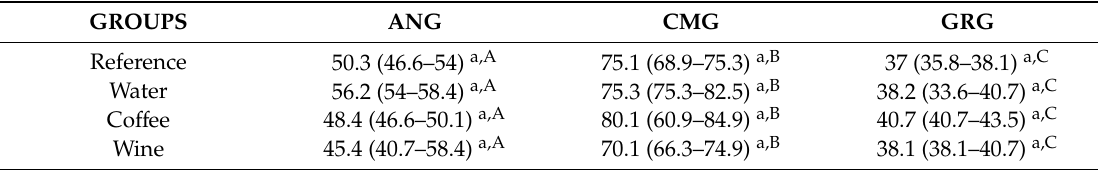
Table 5. Results of the hardness measurements (HV 1kp units) of the materials tested following immersion in water and the staining media (median and 25%–75%